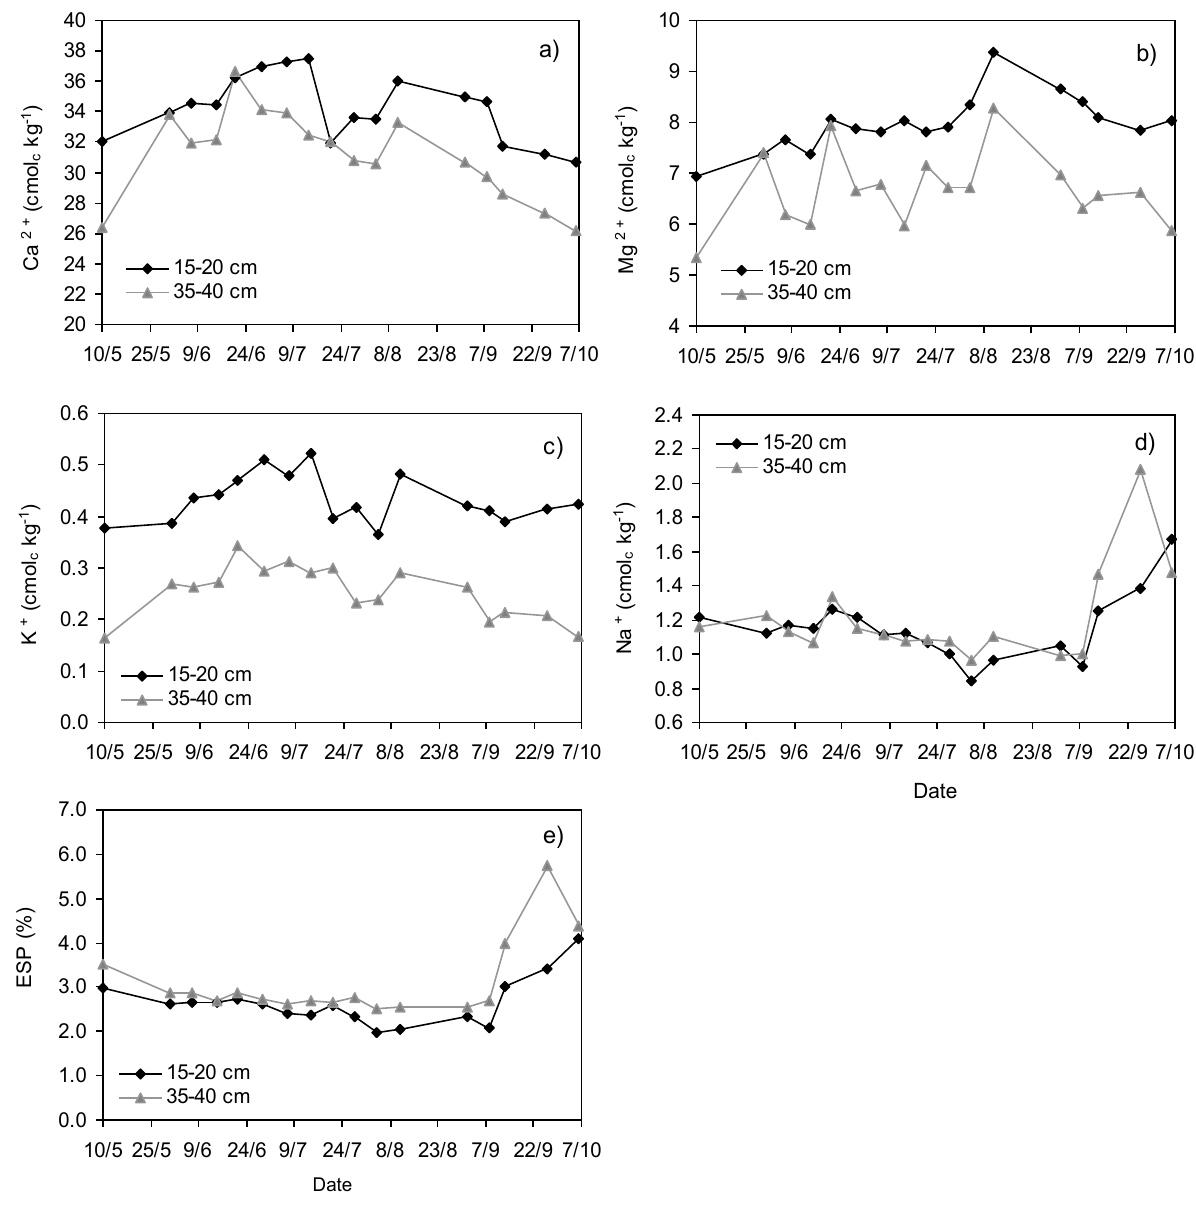
Figure 3. Fluctuation of exchangeable cations during the growing period: ( a ) for Ca 2+ ; ( b ) for Mg 2+ ; ( c ) for K + ; ( d ) for Na + and ( e ) for ESP. The statistical differences of exchangeable Ca 2+ , Mg 2+ , K + and Na + concentrations, before and after the cropping period, are given in Table 3. It is evident from Table 3 that statistical differences are observed only for exchangeable Na + and ESP. Despite the increase of these two parameters after the growing season, their final values are quite low to indicate soil